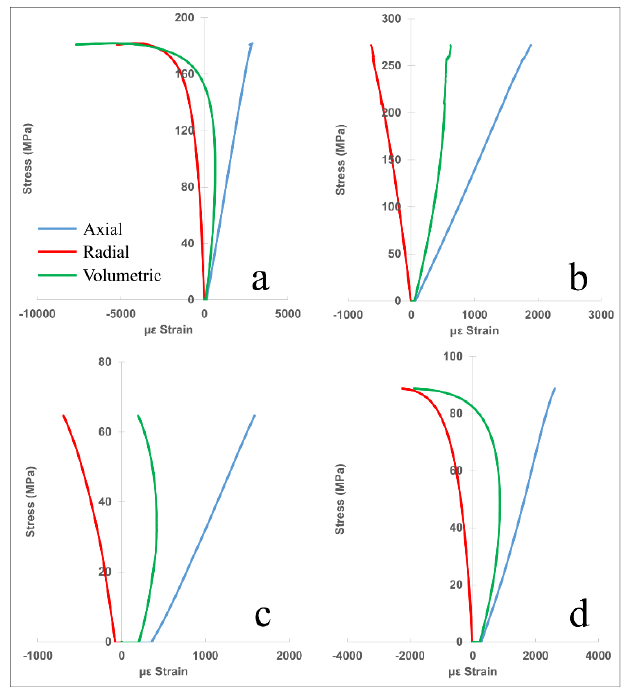
Figure 10. Schematic representations of the stress – strain response and stages of brittle rock fracture process and evolution of the short-term strength of the material to its long-term strength when subjected to a constant stress condition; ( a ) OX-3G, ( b ) OX-4B, ( c ) OX-6C, ( d ) EPN-2B.